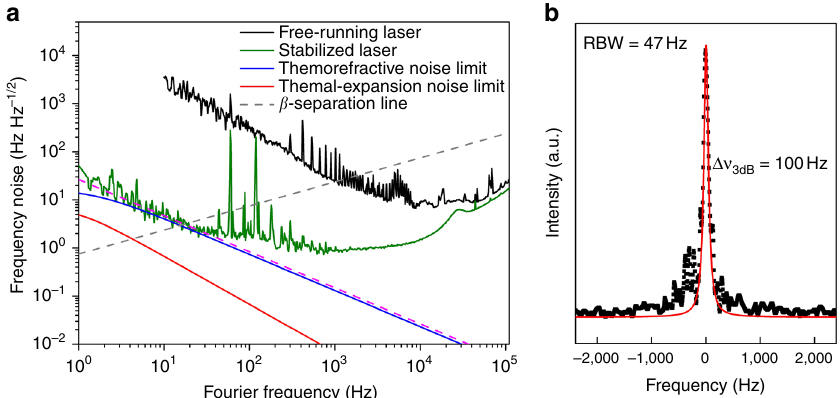
Fig. 3 Frequency noise of the thermal-compensation resonator. a The frequency noise power spectral density (FNPSD) measured by the beat frequency between the laser and the table top Fabry-Pérot (FP) cavity reference laser. The FNPSD of free-running laser used in our experiment ( black curve ) and of the laser stabilized to the compensated resonator ( olive ). The thermodynamical FNPSD predictions from thermorefractive ( blue ) and thermal expansion noise ( red ) are also illustrated for comparison. The thermorefractive noise shows f − 1.5 frequency dependence ( magenta dashed line ) predicted by our theoretical model. b The measured linewidth (fullwidth at half maximum) on a spectrum analyzer with 47 Hz resolution bandwidth (RBW) and 40 ms sweep time over the 5 kHz span, giving a ≈ 100 Hz Lorentzian linewidth fi t. The effective linewidth evaluated from the olive curve is 119 ± 2 Hz and the linewidth without the 60 and 120 Hz power-line noise is determined to be 25 ± 0.3